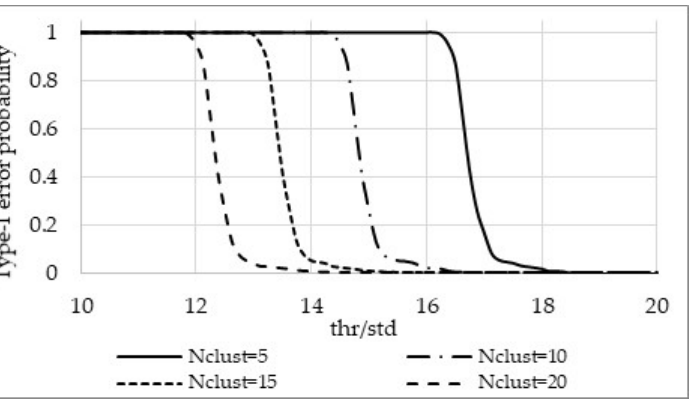
Figure 17. Probability of making a type-I error for a non-stationary friction-induced noise at different N clust .